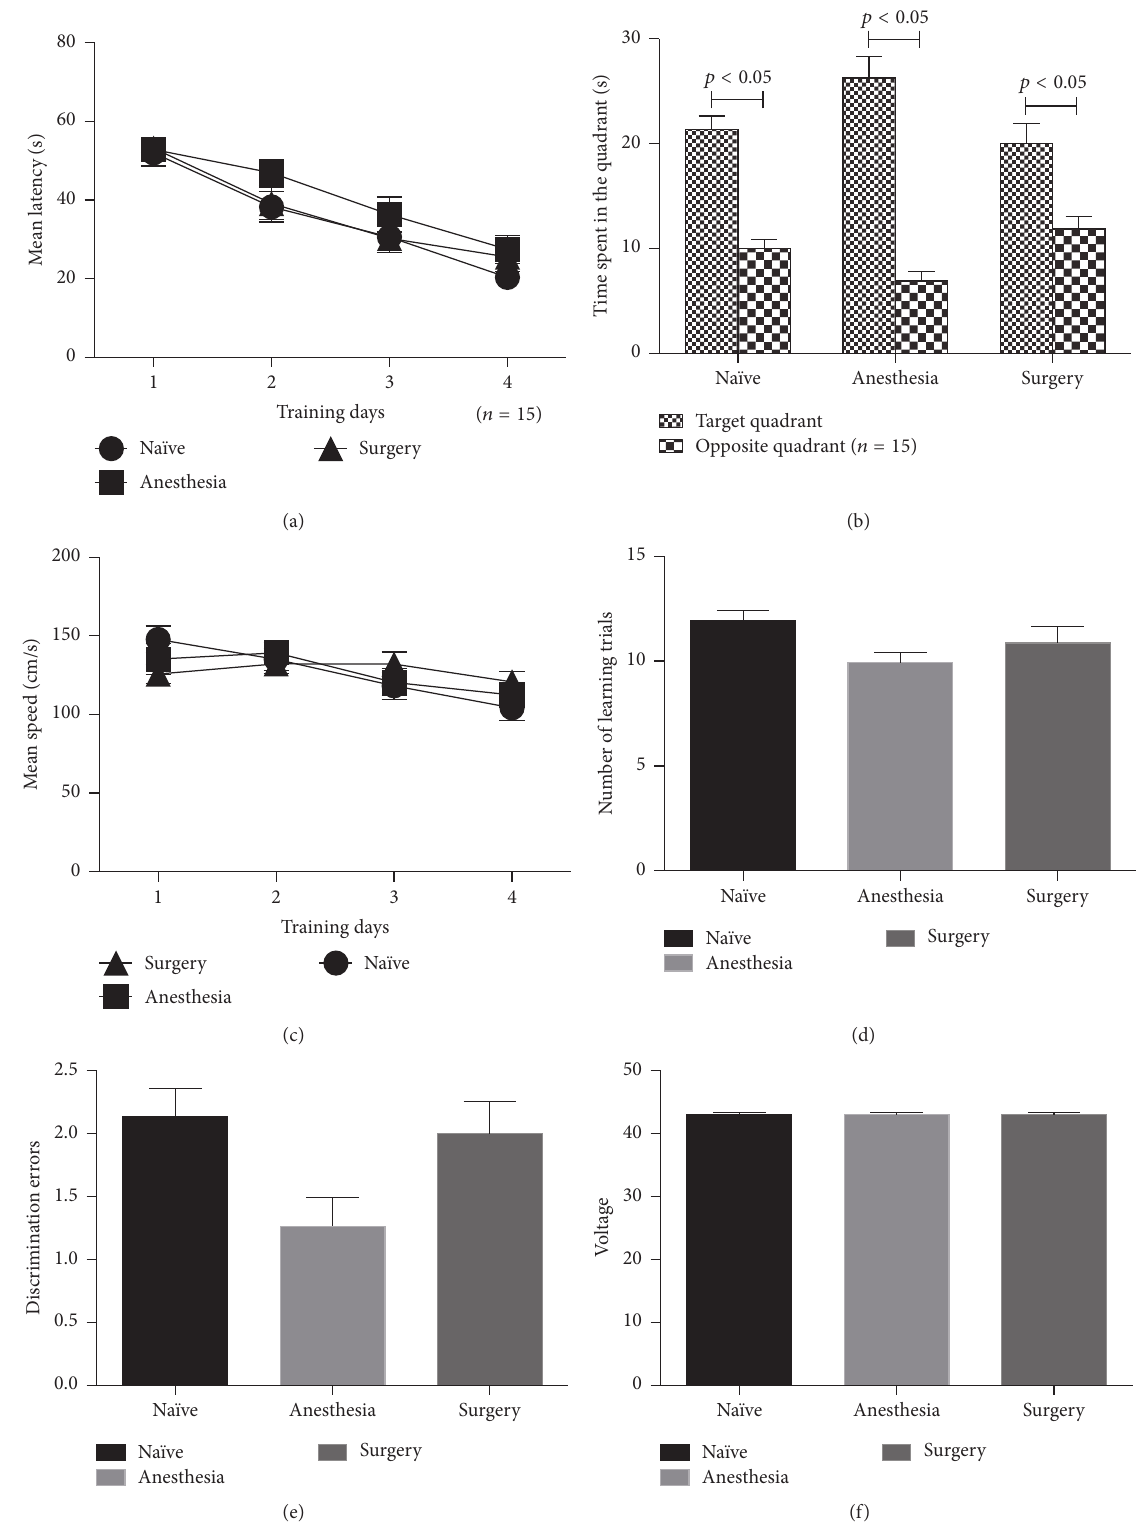
Figure 5: Morris water maze and avoidance learning task test results of long term. No significant differences were observed among the three groups. (a) Mean latency; (b) swimming time in the target quadrant; (c) average swimming speed; (d) the number of learning trials; (e) discrimination errors; (f) shock voltage ( 𝑛 = 15